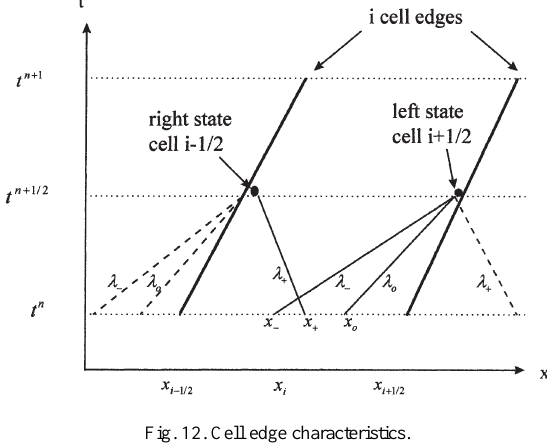
Fig. 12. Cell edge